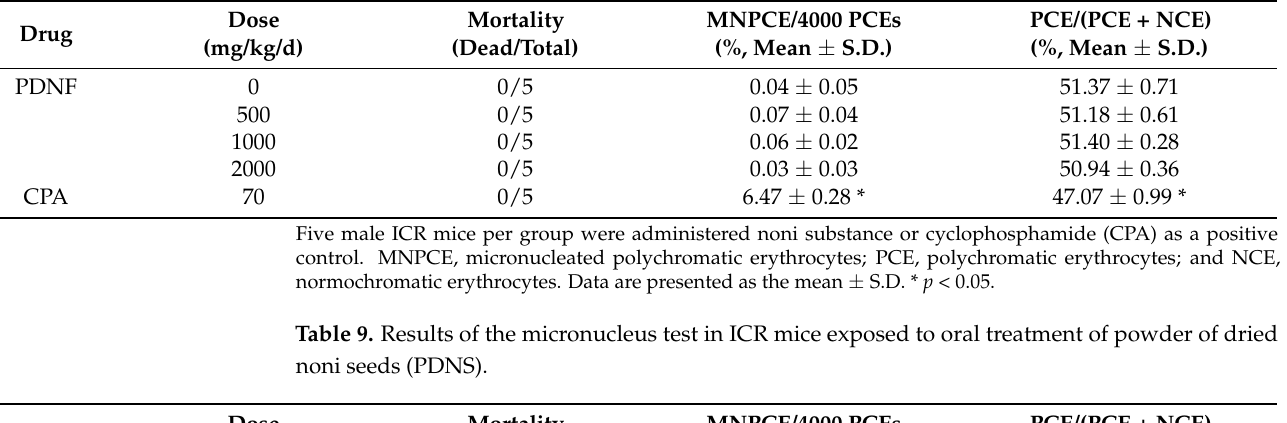
Table 8. The results of the micronucleus test in ICR mice exposed to oral treatment of powder of dried noni fruits (PDNF).